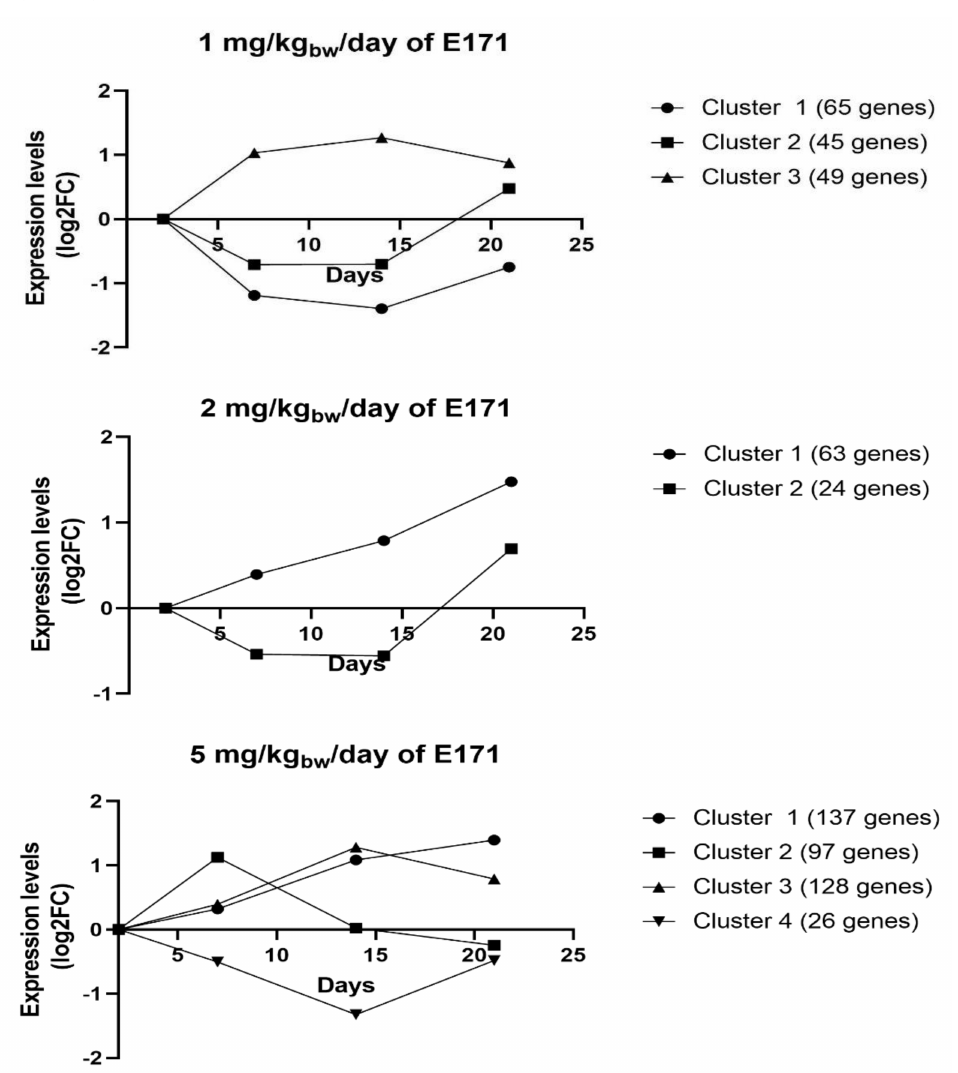
Figure 8. STEM analysis was performed with all genes that passed the preprocessing step to examine their temporality. All significant genes that were assigned to a profile were clustered by biological function and are represented in this figure. The X -axis corresponds with the timepoints 2, 7, 14, and 21 days, and the y -axis indicates the expression based on log2FC. Original STEM output profiles and assigned genes per profile can be found in the y data (Supplementary Tables